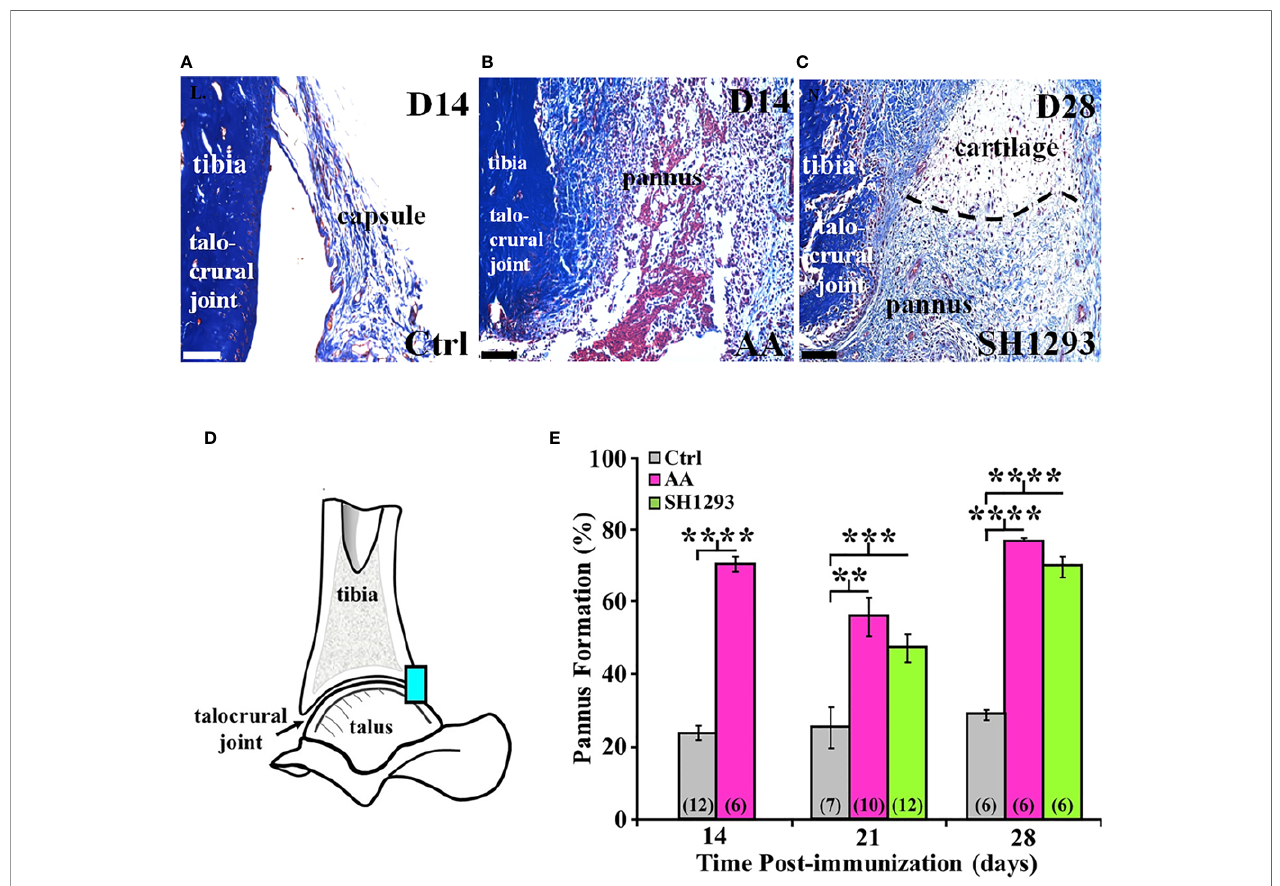
FIGURE 9 | SH1293 Reduced Pannus Formation. In AA and RA, the pannus is fi brovascular or granulation tissue from the hypertrophied synovium with in fi ltration of macrophage- and fi broblast-like mesenchymal cells that secrete collagen-lytic enzymes. Trichrome-stained tissue of the joints from Ctrl (A) or AA and SH1293- treated rats (B, C), respectively. Calibration bars = 100 m m. (A) At D14 in Ctrl rats, collagen fi bers (blue) of fi brous connective tissue form an intact capsule arising from the bone (blue) in the distal tibia; pannus was not present. (B) In rats with AA, destruction of the joint capsule and formation of pannus were evident at D14, accompanied by an in fl ammatory cell in fi ltration, destruction of the capsule, and accumulation of fi brin (red) and collagenous fi bers (blue). (C) At D28, in an SH1293- treated rat, an invasive pannus was apparent in the lower half of the image, as well as a pannus-cartilage interface (dashed lines). Pyknotic chondrocytes (dark purple) were present in lacunae in the cartilage. Subchondral bone (deep blue), adjacent to the pannus was eroded (lower left side of the image). (D) A diagram of the talocrural joint illustrating the ROI for evaluating cartilage area. (E) Morphometric analysis of the pannus. Cartilage area used as a baseline in Ctrl rats did not signi fi cantly differ across experimental days of assessment. Pannus formation in AA rats was more extensive at D14, D21 or D28 compared with the percentage of cartilage area established as baseline in Ctrl rats ( **** p < 0.0001; ** p < 0.01; and **** p < 0.0001, respectively). At D21, pannus formation in SH1293 rats was comparable with AA rats, but was greater ( *** p < 0.001) than Ctrl rats. Similarly, at D28, the percentage of pannus in the arthritic joints from SH1293 rats did not differ from AA rats, but was signi fi cantly greater than Ctrl rats ( **** p < 0.0001). The n ’ s for each group are indicated in parentheses at the base of each